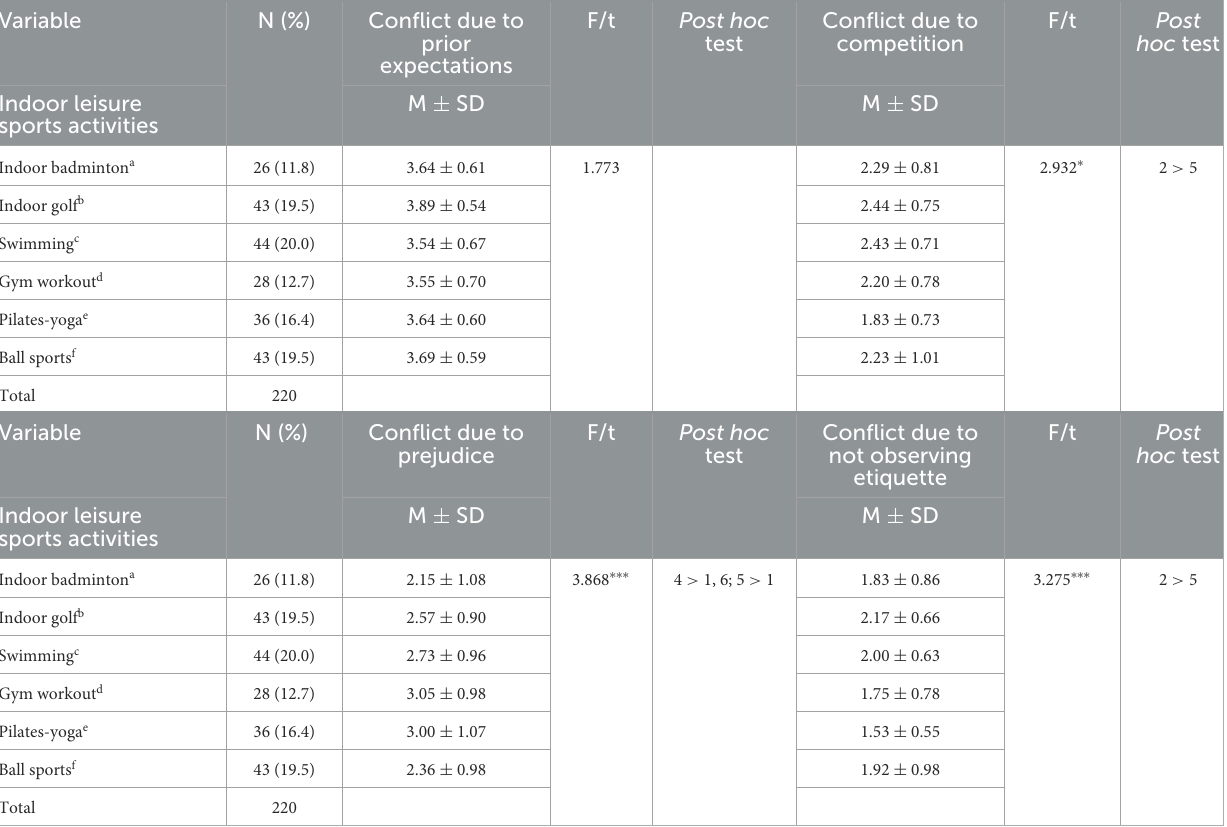
TABLE 1 Differences in leisure conflicts among indoor leisure sports ( N =